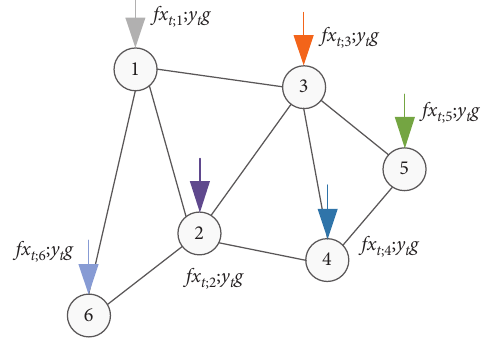
Figure 1: Distributing the features across